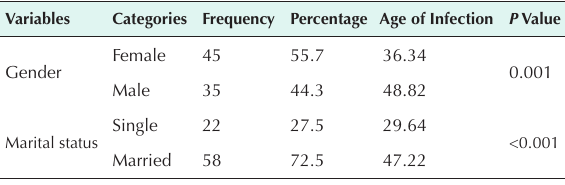
Table 2. The Frequency Distribution of Gender and Marital Status and the Average Age of Infection Based on These 2 Variables